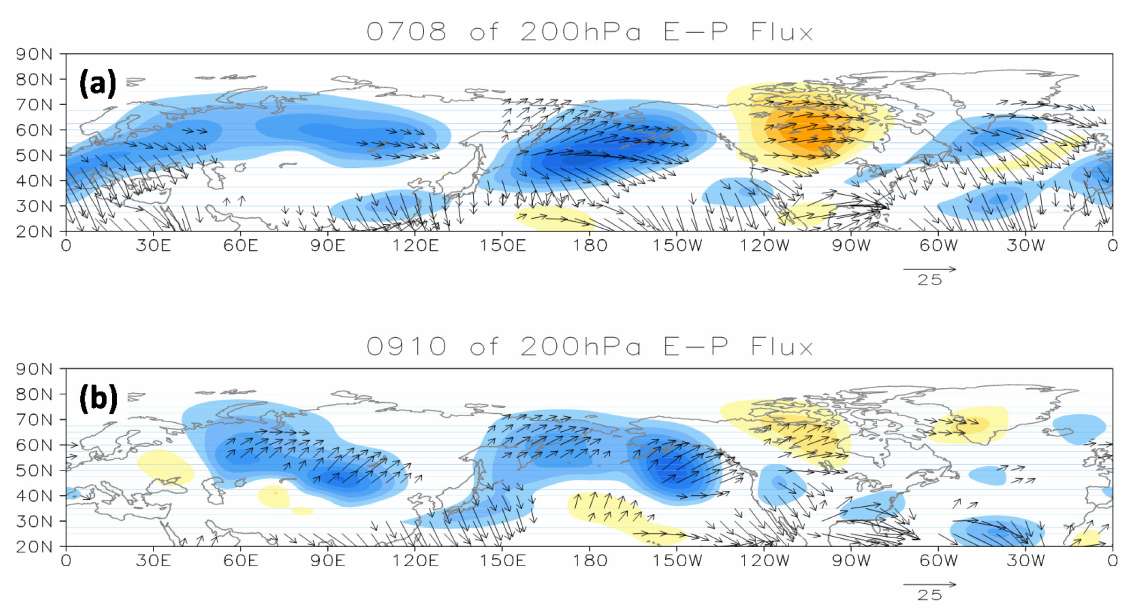
Figure 14. Distribution of the 200 hPa horizontal flux (m 2 · s − 2 ; arrows) and the vertical flux (m 2 · s − 2 ; contours; upwards, blue) of ( a ) the winter of 2007/08 and ( b ) the winter of